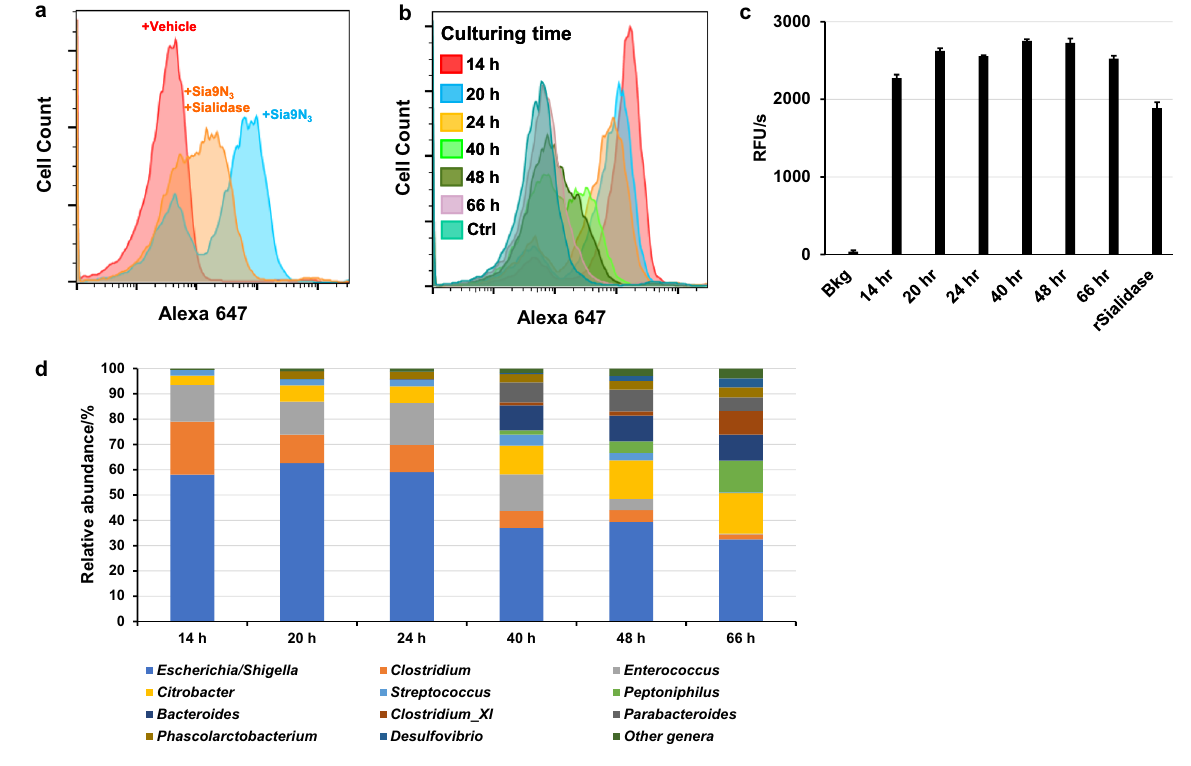
Figure 3. Bacterially incorporated surface Sia9N 3 can be removed by microbial sialidases over time. ( a ) Treatment of labeled microbes before DBCO-BTN conjugation with a recombinant sialidase significantly reduces fluorescence labeling. The incorporated Sia9N 3 is removed by microbial sialidases over time as fluorescence labeling was gradually removed during microbiota cultivation ( b ) and microbial sialidase activity was constantly detected in the culture media, 500 pM recombinant BT0455 was used as a positive control ( c ). ( d ) 16S rRNA gene sequencing revealed the change of taxonomic composition during H2 microbiome culture. “Bkg” stands for background, “rSialidase” stands for recombinant